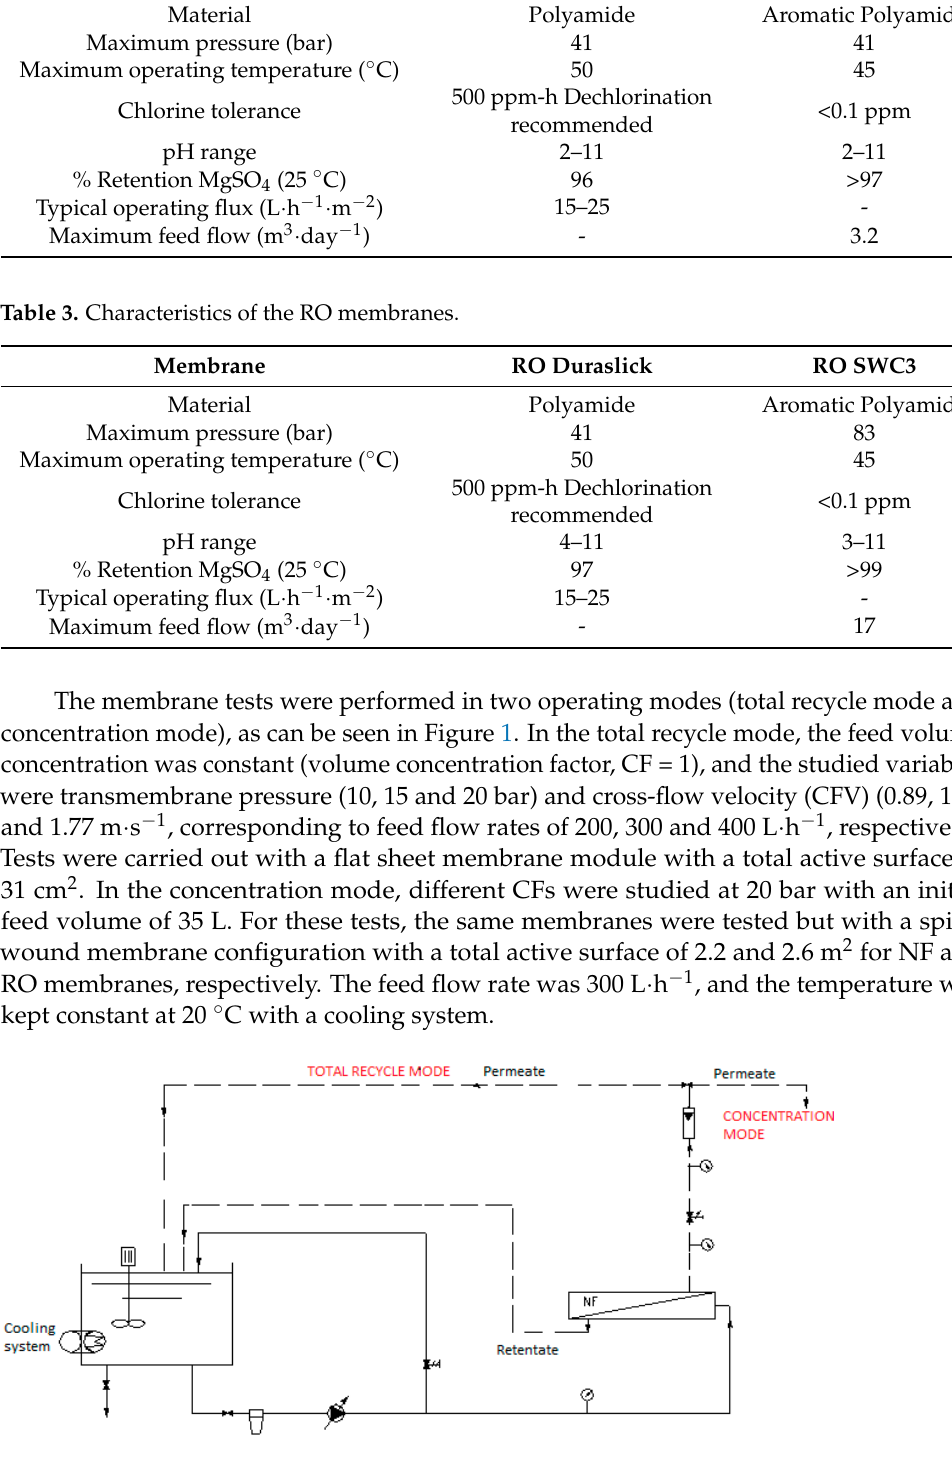
Figure 1. Operating modes. Total recycle and concentration